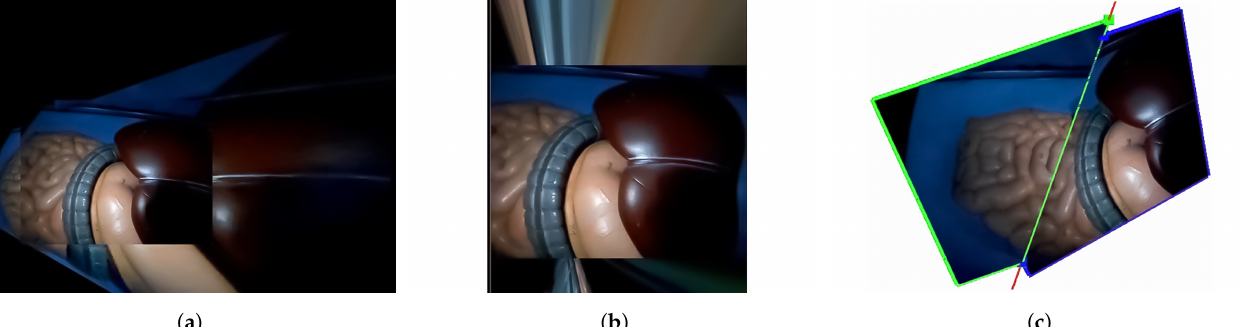
Figure 15. Results of the human model experiment: ( a ) the results of the conventional approach, ( b ) the results of the hybrid tracking and mosaicking approach and ( c ) the results of the proposed approach.